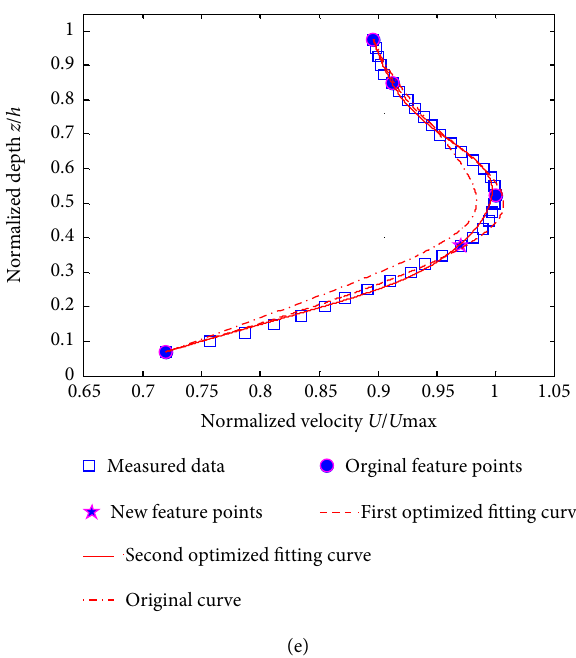
Figure 7: Comparisons between traditional B-spline curve method and NBSC method (a) Flow depth ratio ℎ/𝐷 = 42%. (b) Flow depth ratio ℎ/𝐷 = 50%. (c) Flow depth ratio ℎ/𝐷 = 62%. (d) Flow depth ratio ℎ/𝐷 = 70%. (e) flow depth ratio ℎ/𝐷 =